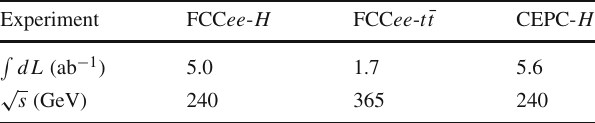
Table 3 Integrated luminosities and center of mass energies for differ- ent experiments at the FCC ee and the CEPC with non-polarized e −